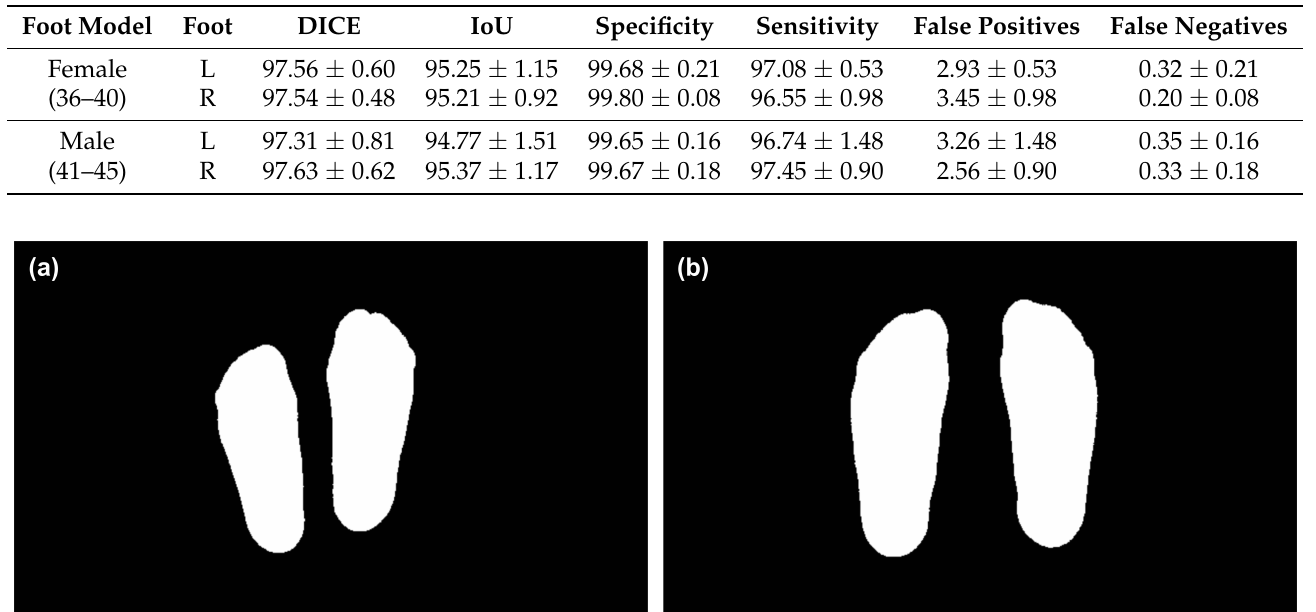
Table 3. Overlap measures for the final models, associated with the right and left feet, for female and male groups of subjects with European foot sizes ranging between 36 and 40 and 41 and 45, respectively. Average values and their corresponding standard deviations are expressed as percentages.